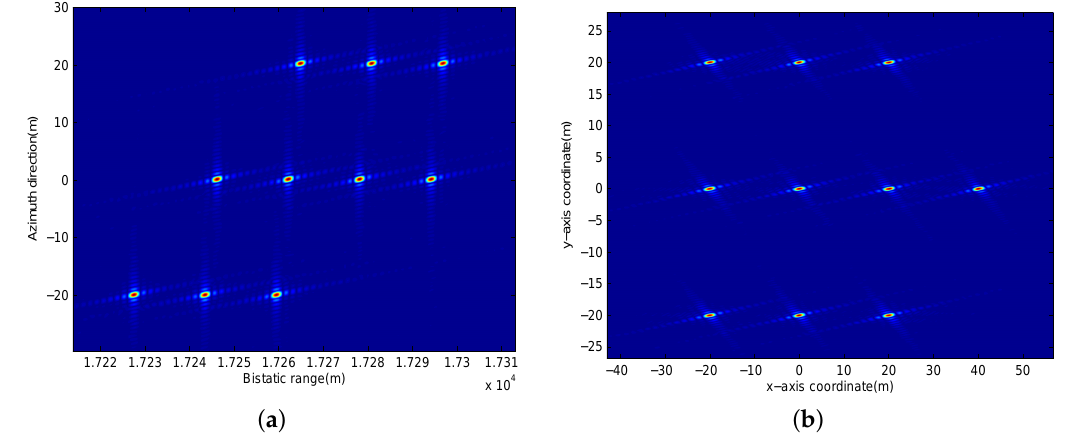
Figure 8. Imaging result of the moving target for BFSAR. ( a ) Before geometric rectification; ( b ) After geometric